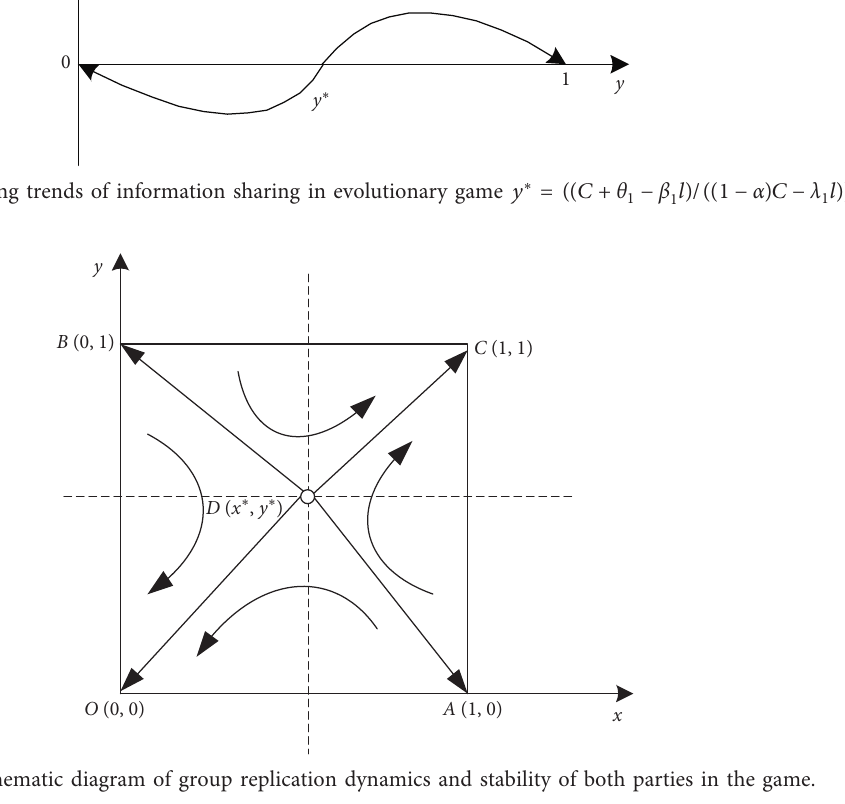
Figure 3: Schematic diagram of group replication dynamics and stability of both parties in the game.